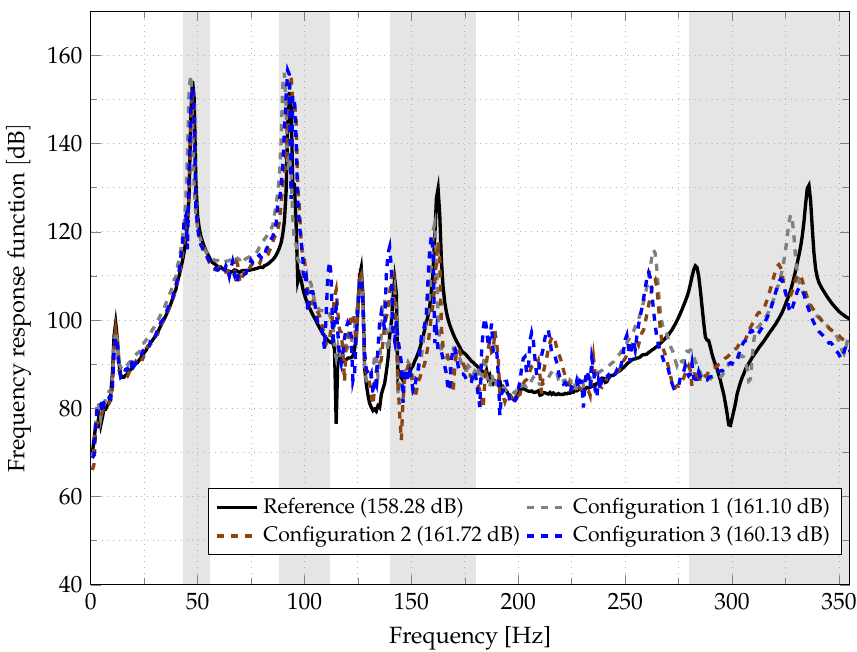
Figure A12. Narrow band spectrum representation of FRF of WTS test specimen for three different configurations. SL value of surface velocity is given in dB.